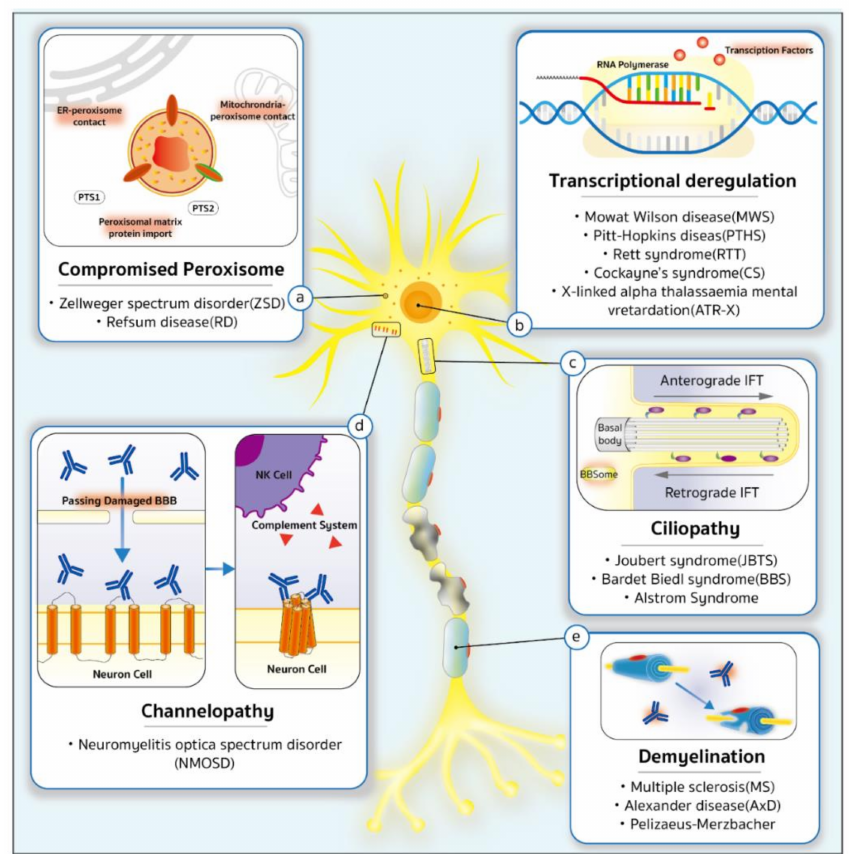
Figure 1. Five categories of pathology of cerebral visual impairments. ( a ) Compromised peroxi- some diseases occurring because of deformation of peroxisomes or failure in peroxisomal protein transportation; ( b ) transcriptional deregulation diseases resulting from mutant transcription factors; ( c ) ciliopathies caused by instability of transportation and structure in the cilia; ( d ) Channelopathies resulting in cytotoxicity; ( e ) demyelinations associated with abnormal immune